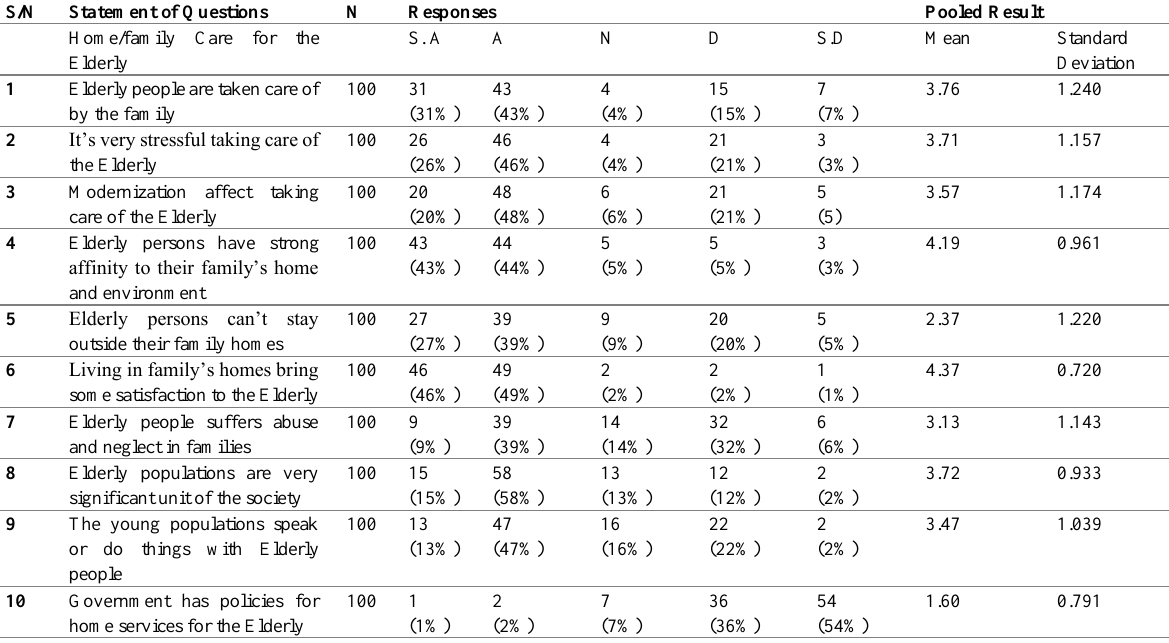
Table 1: Home/Family care for the